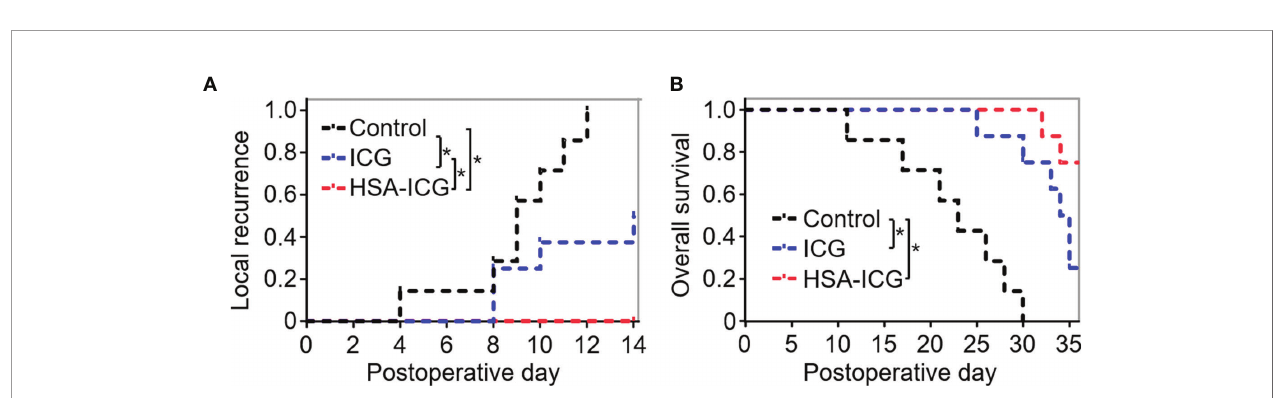
FIGURE 7 | Local recurrence and overall survival of MDA-MB-231-luc tumor-bearing mice after fl uorescence-guided surgery. (A) Local recurrence within 2 weeks for mice that underwent resection under the guidance with HSA-ICG (n = 8 animals), ICG (8) or the control group (7). (B) Overall survival of the same mice as (A) . (log-rank test, * P < fl uorescence signal of the resected tissue with fi nal histopathology. rate reported in a previous study (two of 22 mice) (12). It may be related with the usage dose of ICG, which was higher in previous study (7 vs 1 mg ICG per kg).